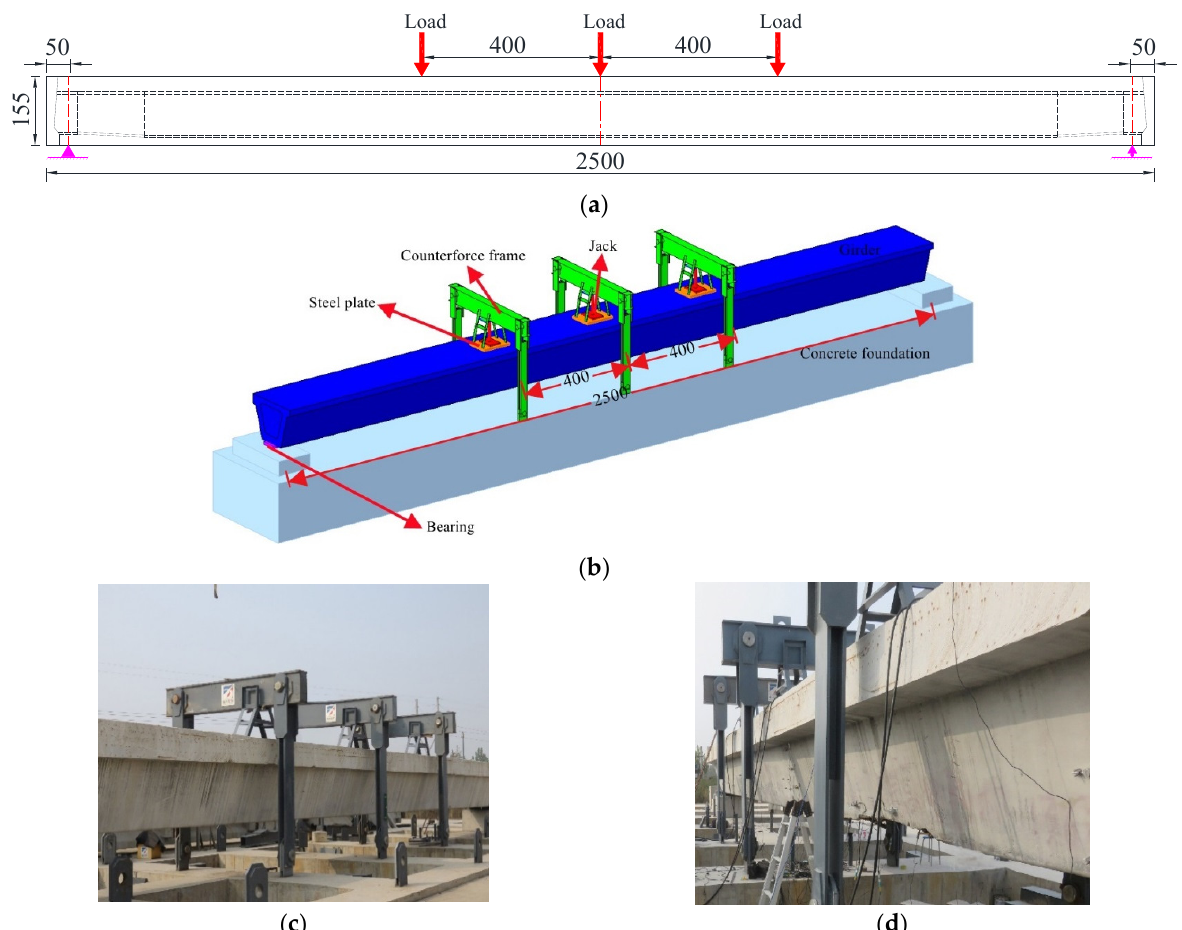
Figure 7. Destructive loading layout (Unit: cm). ( a ) Loading location; ( b ) Schematic loading arrangement; ( c ) Right view of field loading system; ( d ) Left view of field loading system.